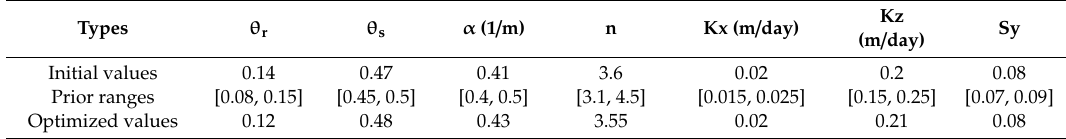
Table 3. Model parameter values.